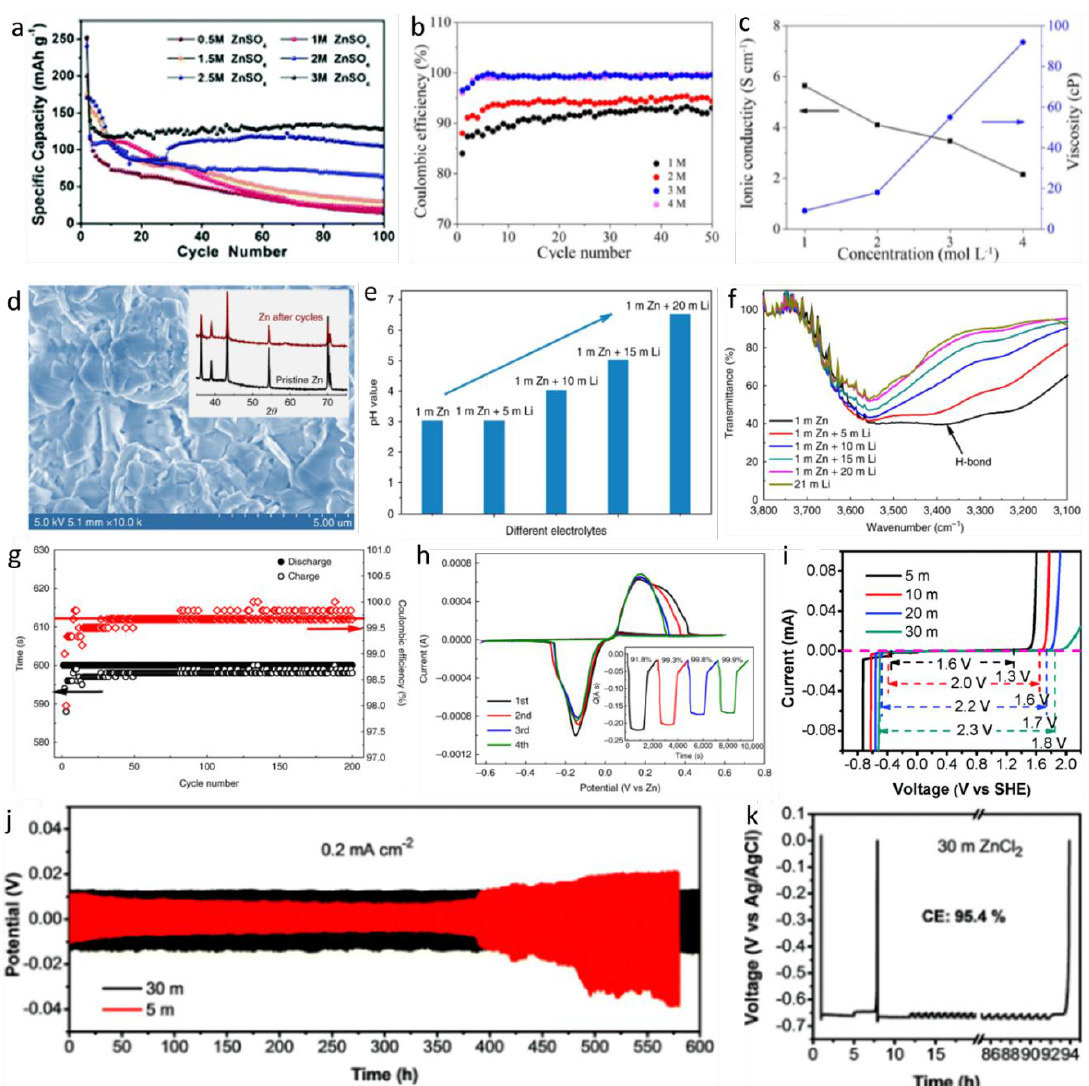
Figure 13. ( a ) Specific capacity and cycle of Zn/V 2 O 5 at different concentrations of ZnSO 4 electrolyte (Reproduced with permission [146] Copyright 2018, Royal Society of Chemistry). ( b ) Coulombic efficiency as a function of cycle number of Zn/ZnMn 2 O 4 and ( c ) viscosity and ionic conductivity at different Zn(CF 3 SO 3 ) 2 electrolyte concentrations. (Reproduced with permission [134] Copyright 2016, American Chemical Society). ( d ) SEM image and XRD pattern (inset) of a Zn anode after 500 stripping/plating cycles in 1 m Zn(TFSI) 2 + 20 m LiTFSI, ( e ) the pH values of the electrolytes with increasing LiTFSI concentrations, ( f ) FTIR spectra with increasing LiTFSI concentrations, ( g ) the Zn plating/stripping time and Coulombic efficiency on a Pt working electrode at 1 mA cm − 2 , and ( h ) cyclic voltammogram of Zn plating/stripping at a scan rate of 1 mV s − 1 . (Reproduced with permission [140] Copyright 2018, Springer Nature). ( i ) Electrochemical stability window at different ZnCl 2 electrolyte concentrations, ( j ) the plating/stripping of Zn in 30 m and 5 m ZnCl 2 in a Zn (cid:107) Zn symmetric cell at 0.2 mA cm − 2 , and ( k ) Coulombic efficiency Zn (cid:107) Zn symmetric cell in 30 m ZnCl